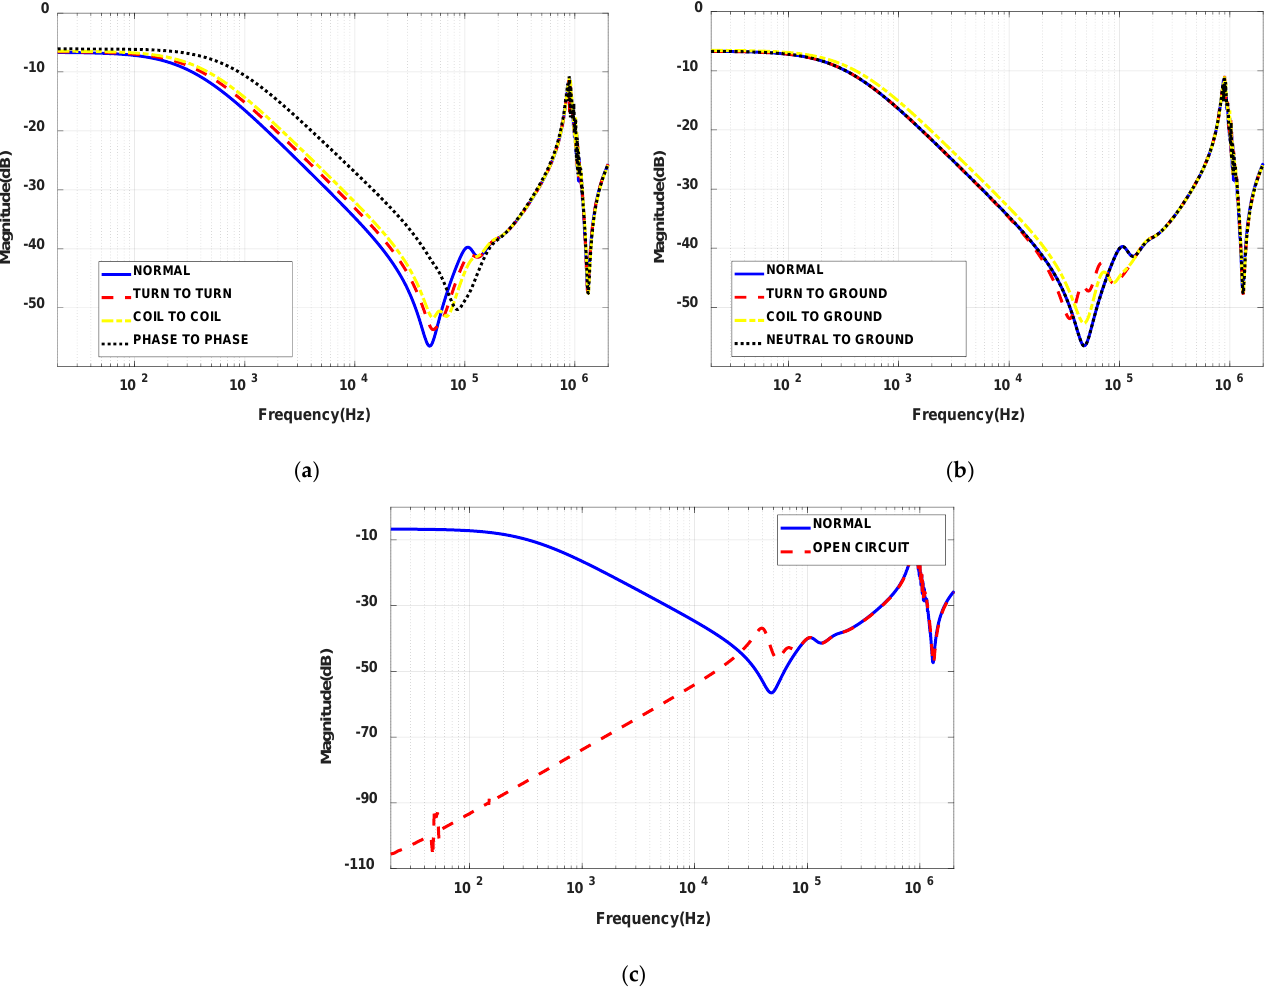
Figure 8. U–V FRA measured responses for the tested IM with stator star connection for ( a ) Normal vs turn − to − turn, coil − to − coil and phase − to − phase SC faults and ( b ) Normal vs turn − to − ground, coil − to − ground, and neutral − to − ground SC faults. ( c ) Normal vs. OC fault.